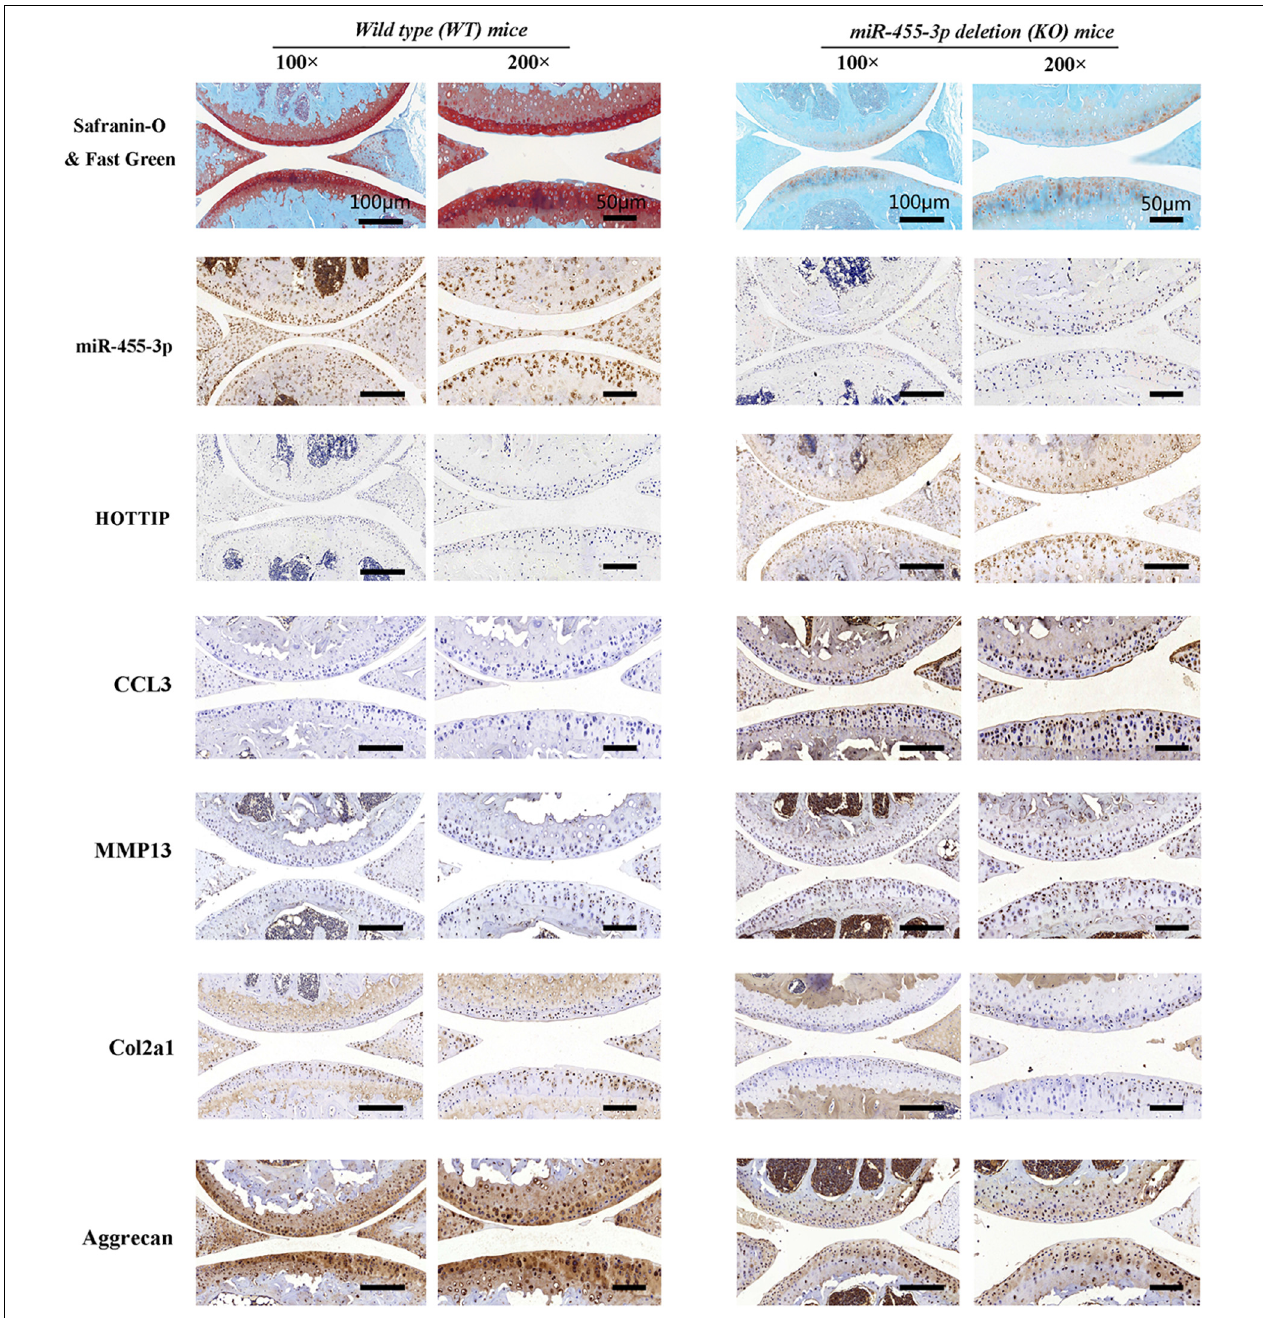
FIGURE 7 | miR-455-3p deletion (KO) mice accelerated cartilage degeneration. Safranin O & Fast green staining, immunohistochemistry (col2a1, aggrecan, MMP13, and CCL3) and in situ hybridization (miR-455-3p and HOTTIP) analysis of the knee joint in 12-month-old mice. miR-455-3p deletion enhanced the expression of HOTTIP and CCL3 and accelerated a cartilage degeneration. Data shown are representative of results from five wild-type mice or miR-455-3p-deficient (KO) mice. Scale bar: 50 µ